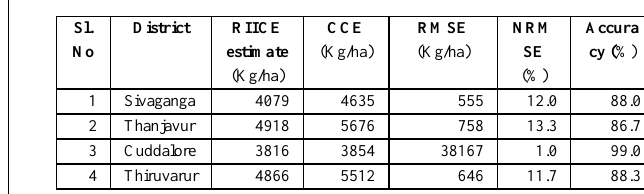
Table 5. Rice yield estimates at block level.